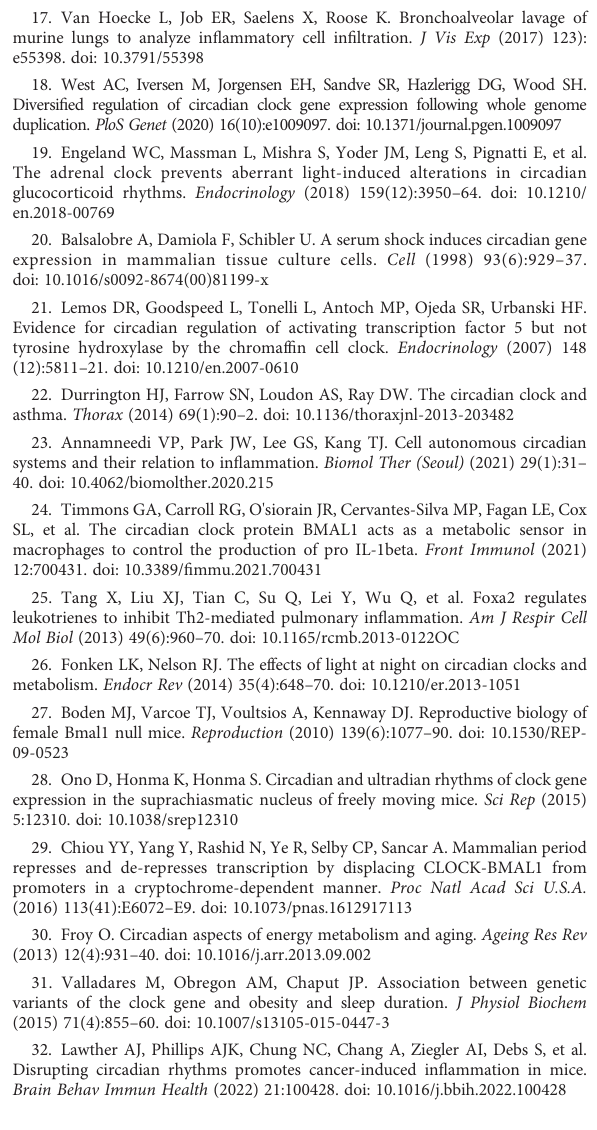
SUPPLEMENTARY TABLE 5 Pearson ’ s correlation coef fi cient for the concentrations of circadian